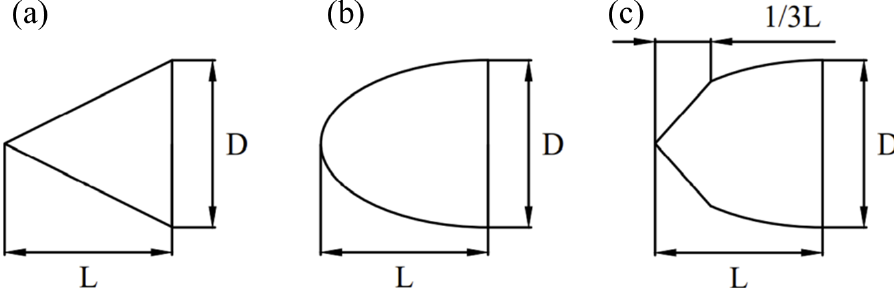
Figure 2. Schematic of three shapes of spinner models: ( a ) conical shape; ( b ) elliptical shape; ( c ) coniptical shape.